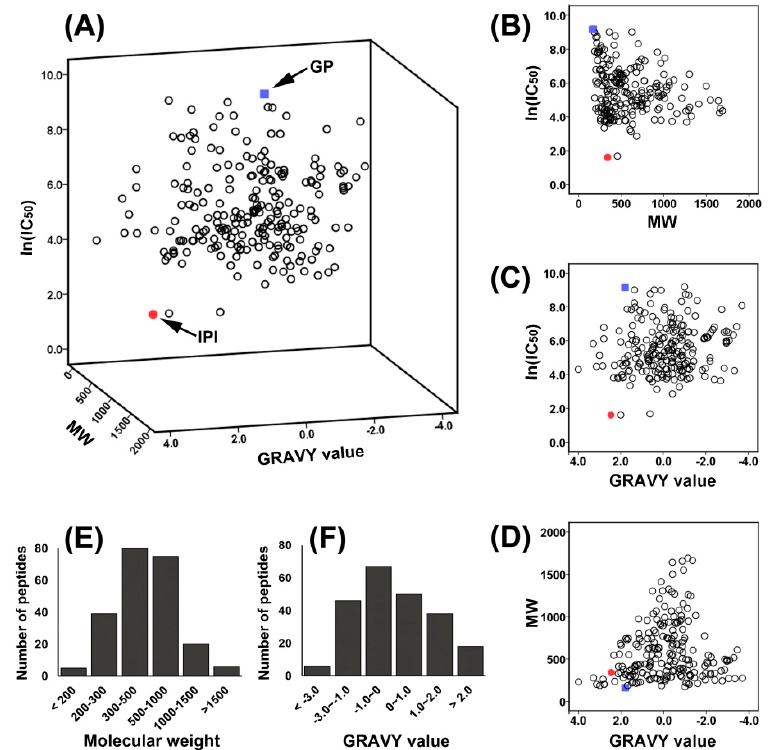
Figure 2. Distribution of known DPP-IV inhibitory peptides. Red dot: tripeptide IPI. Blue square: dipeptide Gly-Pro (GP). ( A ) 3D distribution of 222 peptides based on their IC 50 , MW, and GRAVY values; ( B ) distribution of 222 peptides according to IC 50 and MW; ( C ) distribution of peptides according to IC 50 and GRAVY values; ( D ) distribution of peptides according to MW and GRAVY values; and ( E ) and ( F ) MW and GRAVY value distributions of the 222 peptides, respectively, based on the total number of peptides.